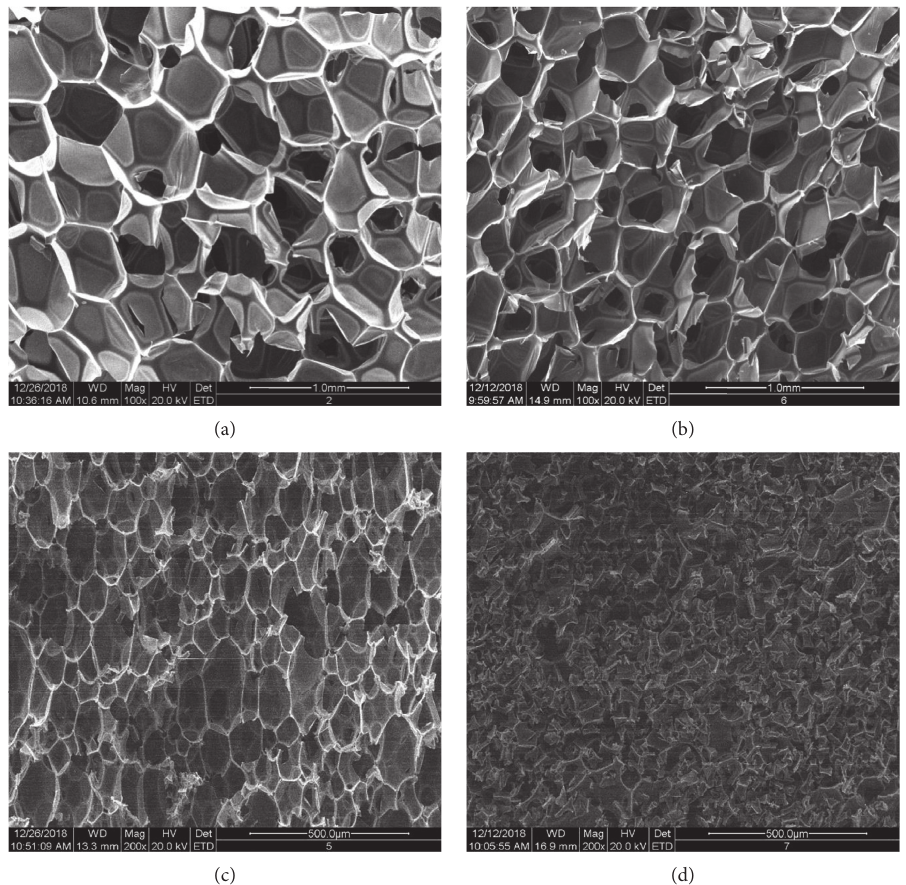
Figure 12: Micropore structures of the thermal insulation materials. (a) Polyurethane insulation that is not freeze-thawed. (b) Polyurethane insulation freeze-thawed 50 times. (c) Polyphenolic insulation that is not freeze-thawed. (d) Polyphenolic insulation freeze-thawed 50 times.